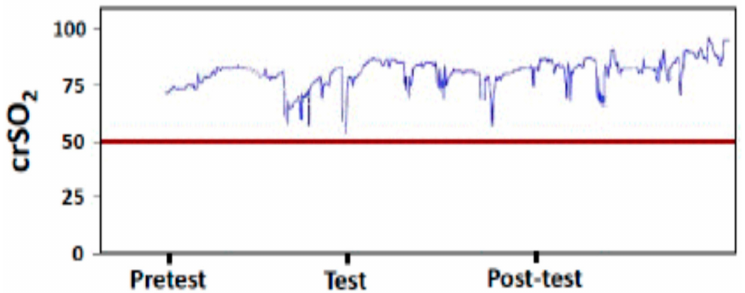
Figure 1. Cerebral regional oxygen saturation (crSO 2 ) pattern recorded before, during and after osteopathic manipulation treatment.